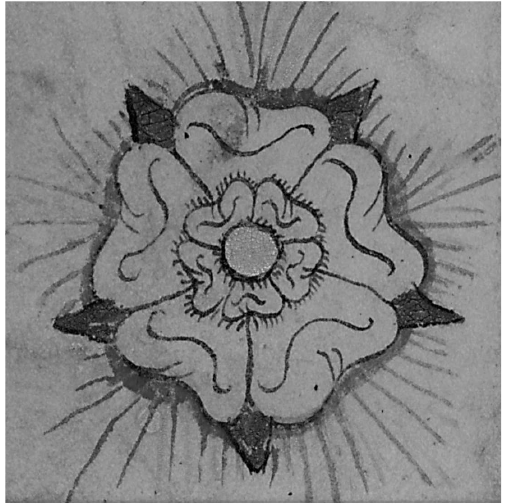
Figure 1. An heraldic rose (the white rose of York) taken from FLP MS Lewis E 201 (public